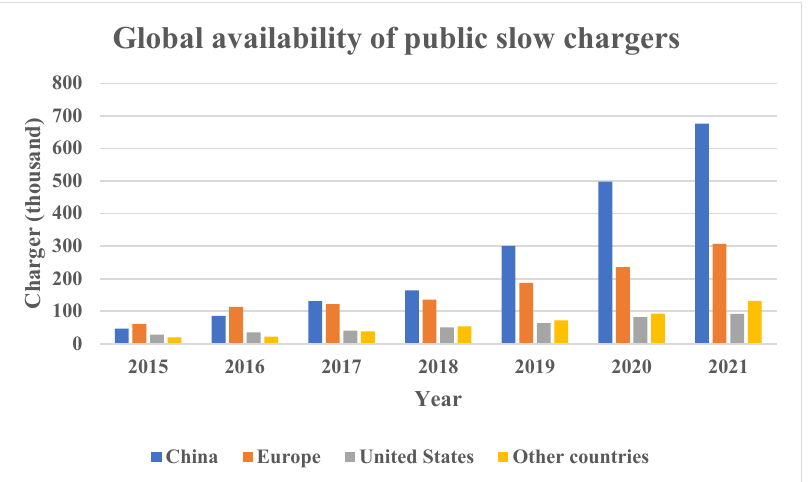
Figure 5. Global availability of slow public chargers [39].